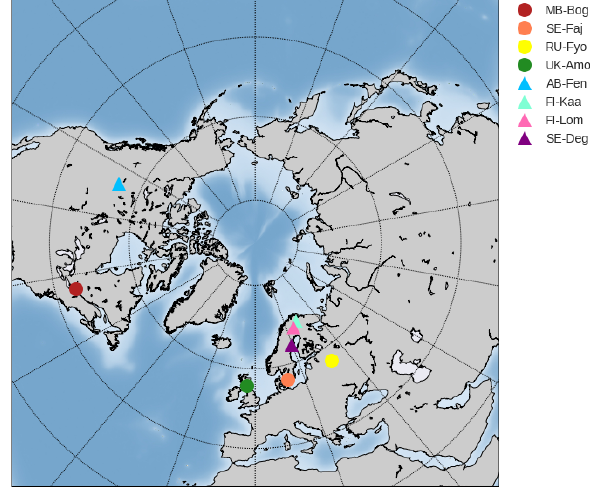
Figure 3. Locations of the test peatlands; closed circles indicate bogs and triangles indicate